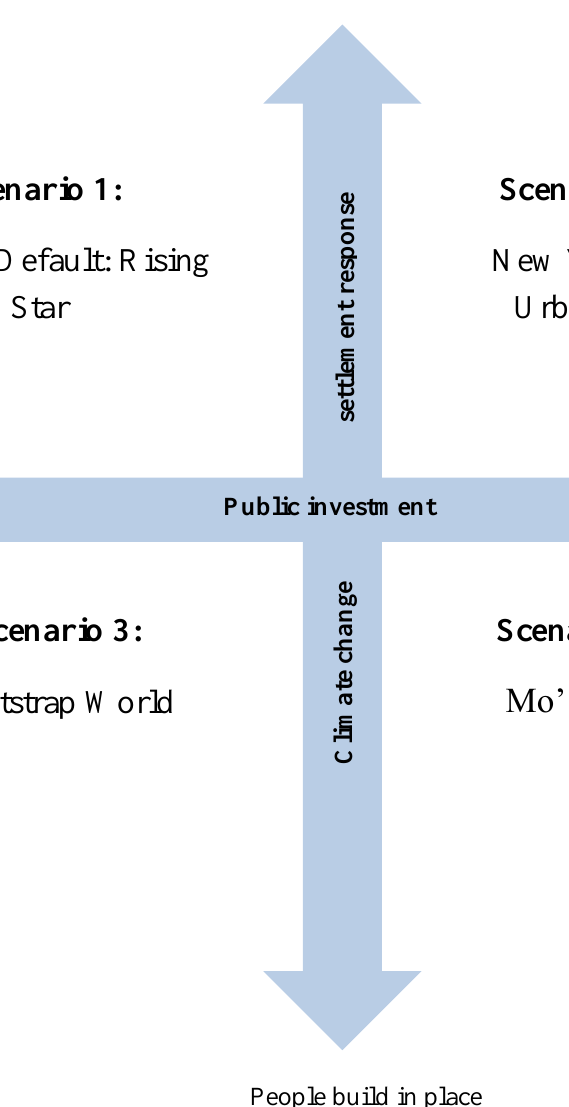
Fig. A2.4. Connecticut scenario